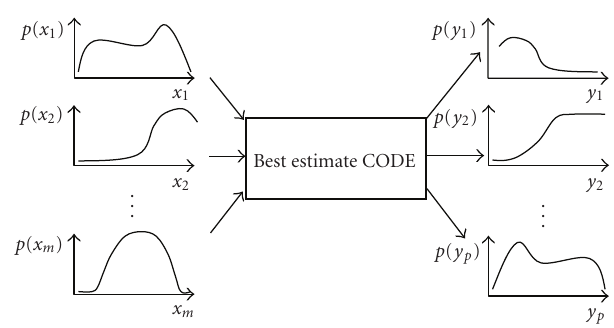
Figure 1: Representation of the best estimate code as a black